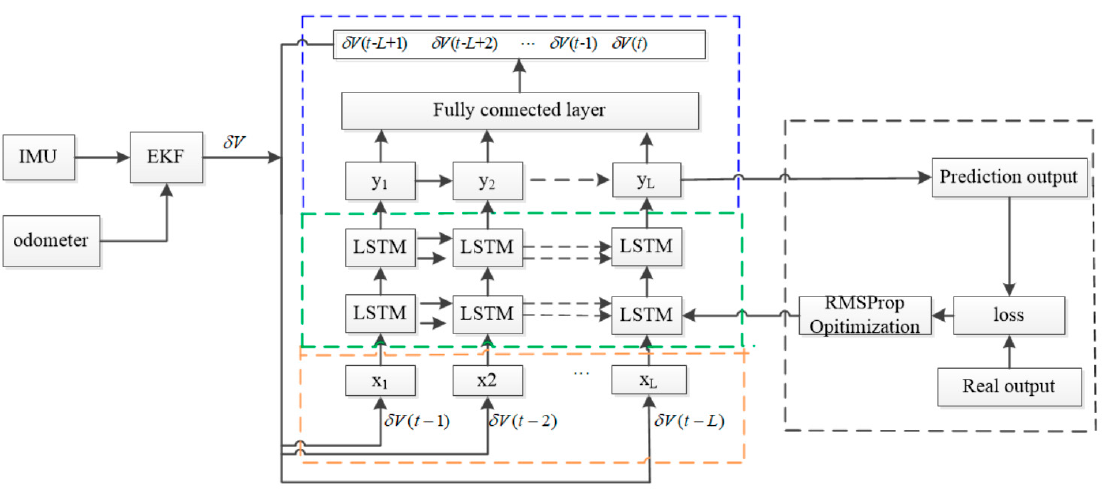
Figure 6. Training process.